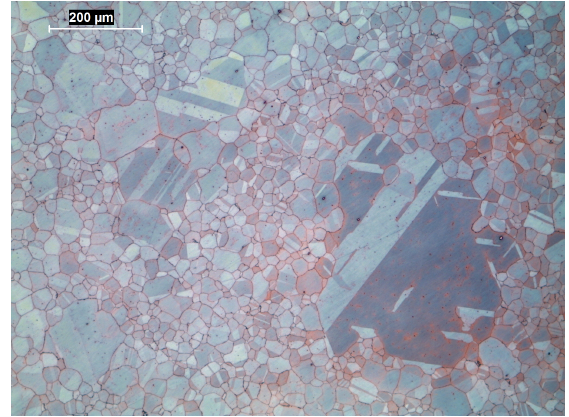
Figure 5. Image showing the austenitic microstructure in Bar B